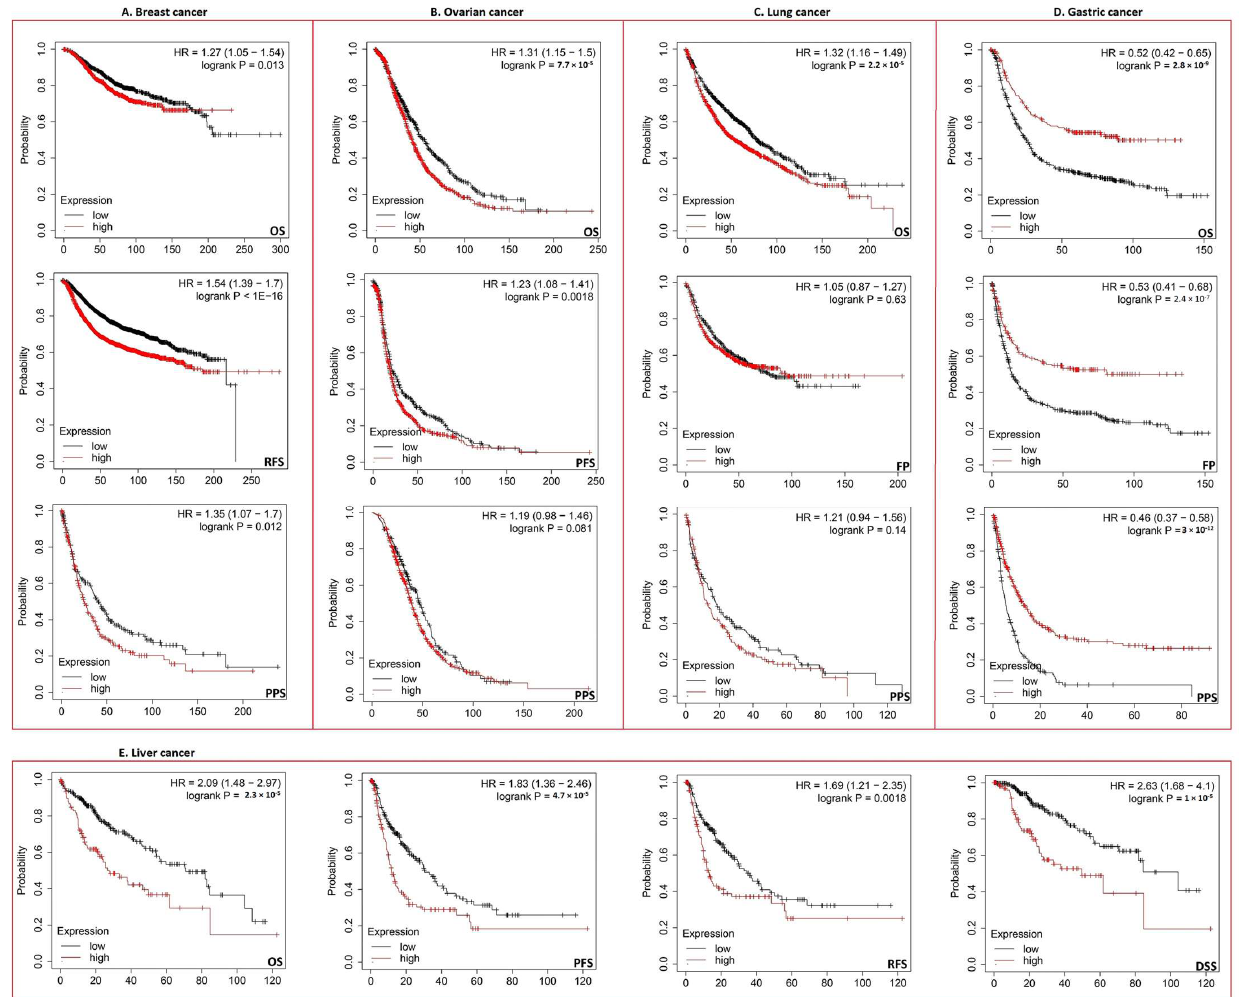
Figure 4. The correlation between ECT2 expression and the survival prognosis as assessed with the Kaplan–Meier plotter tool for ( A ) breast, ( B ) ovarian, ( C ) lung, ( D ) gastric, and ( E ) liver cancer.